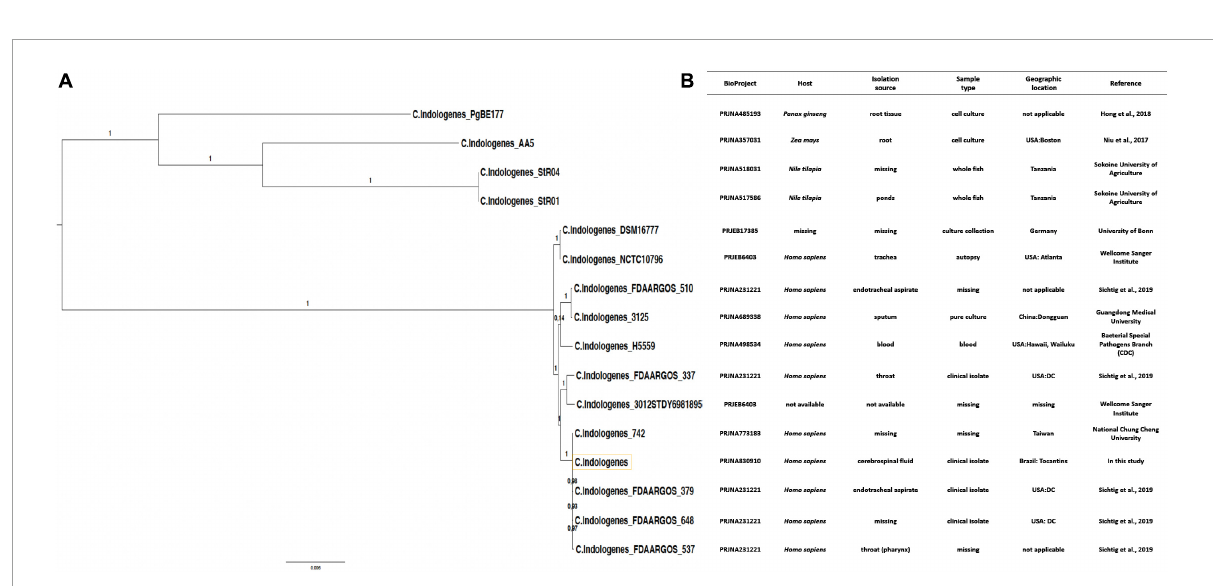
FIGURE4 (A) Phylogenetic tree showing the evolutionary similarity between C. indologenes and other 15 selected strains of Chryseobacterium indologenes . (B) Genome Assembly and Annotation report (https://www.ncbi.nlm.nih.gov/genome/browse/# ! /prokaryotes/14653/) of 16 strains of C. indologenes . The yellow box represents our